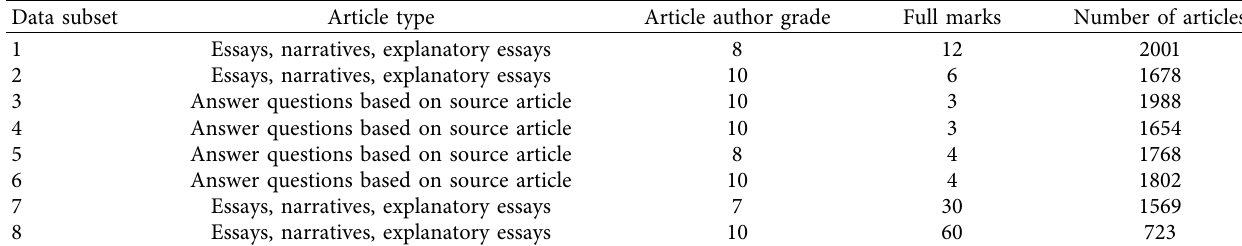
Table 1: Data set description.